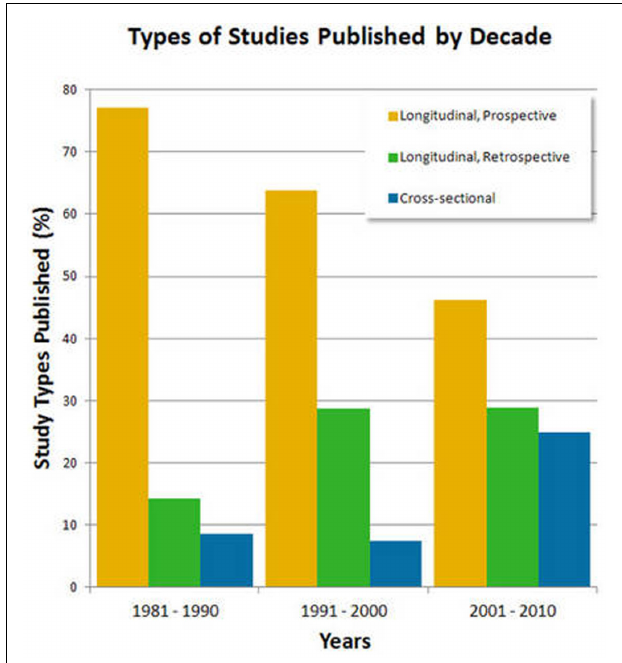
FIGURE 3 | Changes in study design over time. There are proportionally fewer and fewer prospective longitudinal studies being published. Proportionally more and more retrospective and cross-sectional studies are being published.